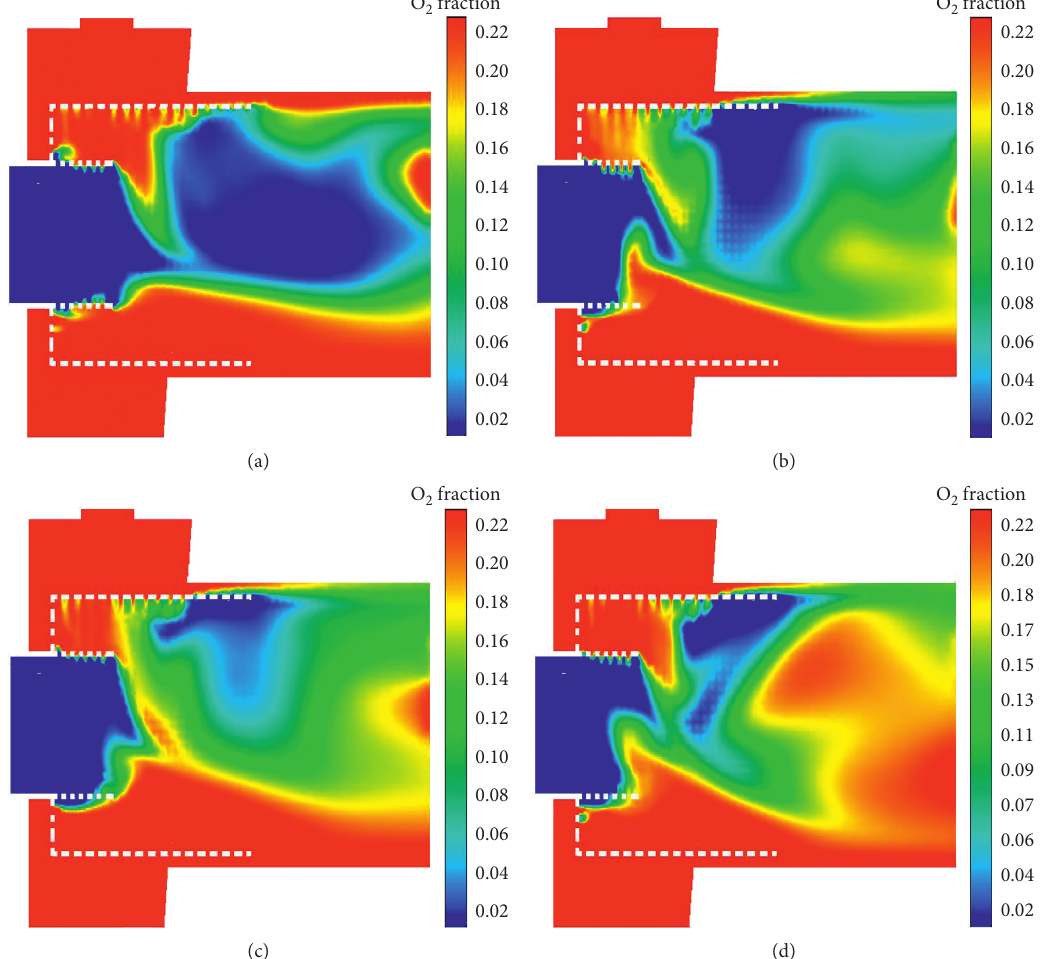
Figure 12: Longitudinal distribution of the O α � 1.4. (c) α � 1.8. (d) α � 2.2.